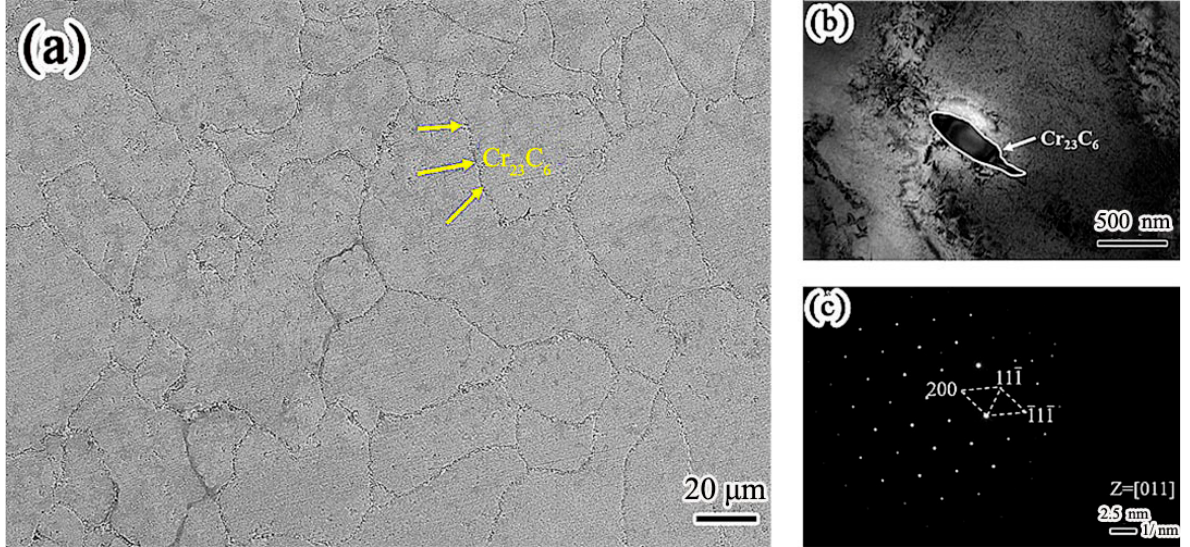
Figure 3. Microstructure of the Inconel 625 weld cladding. ( a ) Precipitates of the Inconel 625 weld cladding. ( b ) Bright field image. ( c ) Diffraction spot.